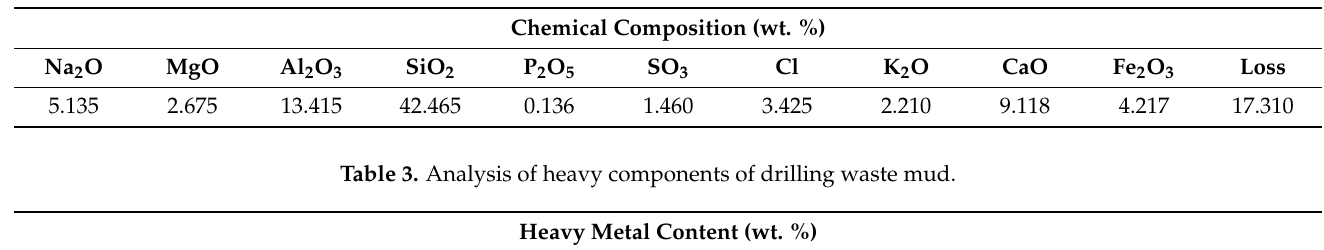
Table 2. Chemical composition of drilling mud.